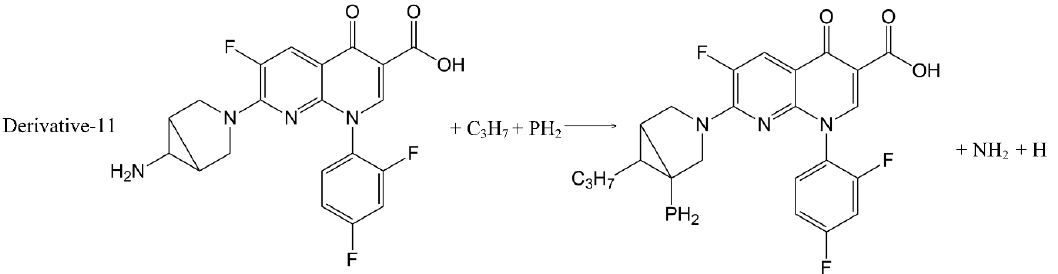
Figure 3. Substitution reaction paths of quinolone derivatives. Table 5. Gibbs free energy change ( ∆ G) of quinolones’ substitution reaction paths. Gibbs Free Energy/(a.u.) Reaction Paths ∆ G / (kcal · mol − 1 ) For